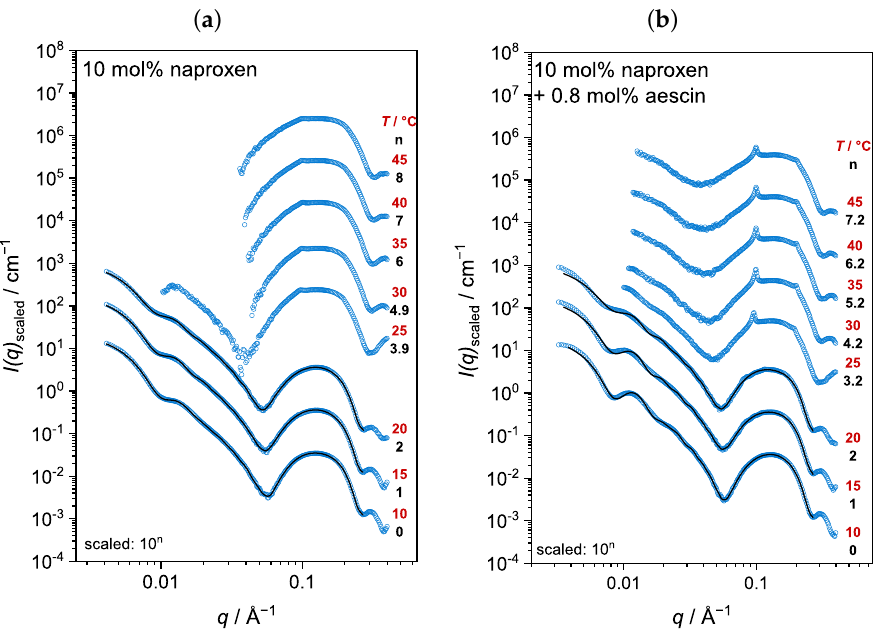
Figure 5. SAXS curves of ( a ) DMPC vesicles with 10mol% naproxen and ( b ) vesicles with 10mol% naproxen and 0.8mol% aescin at different temperatures (see red numbers on the right). Scattering curves were scaled by powers of 10 for better visibility. Solid lines are IFT approximations to the scattering